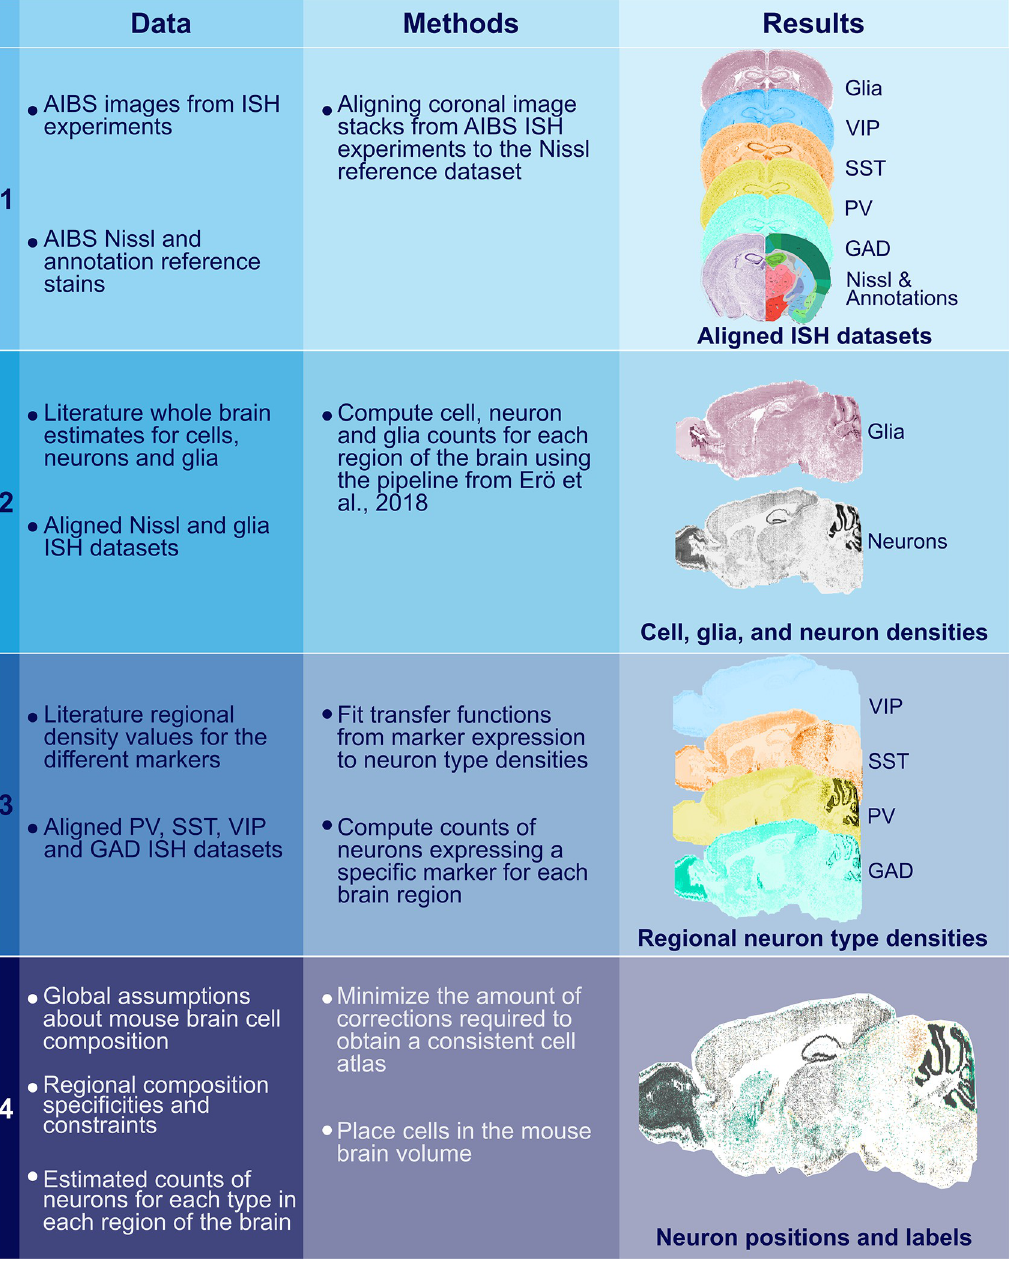
Fig 1. New workflow for the Blue Brain Mouse Cell Atlas (BBCAv2). Steps of the pipeline are displayed in rows with the data consumed in the left column, the method used in the middle column, and the produced results on the right. Each step of this pipeline builds on the results of the previous